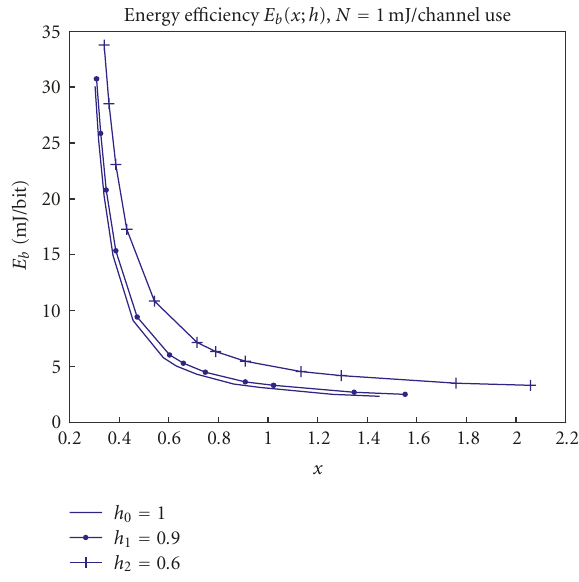
Figure 1: Energy-e ffi ciency over fading